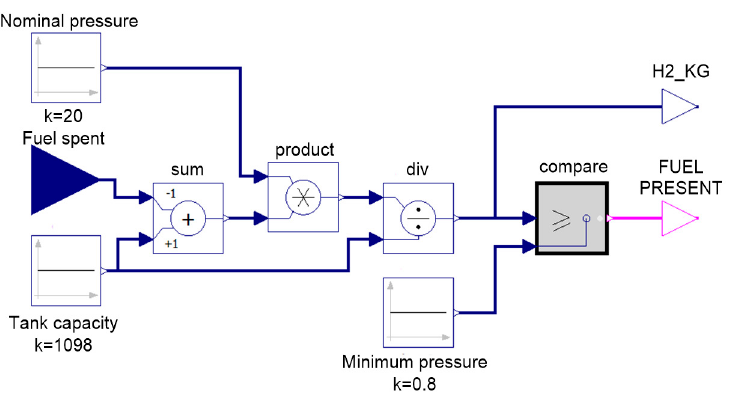
Figure 16. Model of a PEM hydrogen fuel cell developed in Modelica.